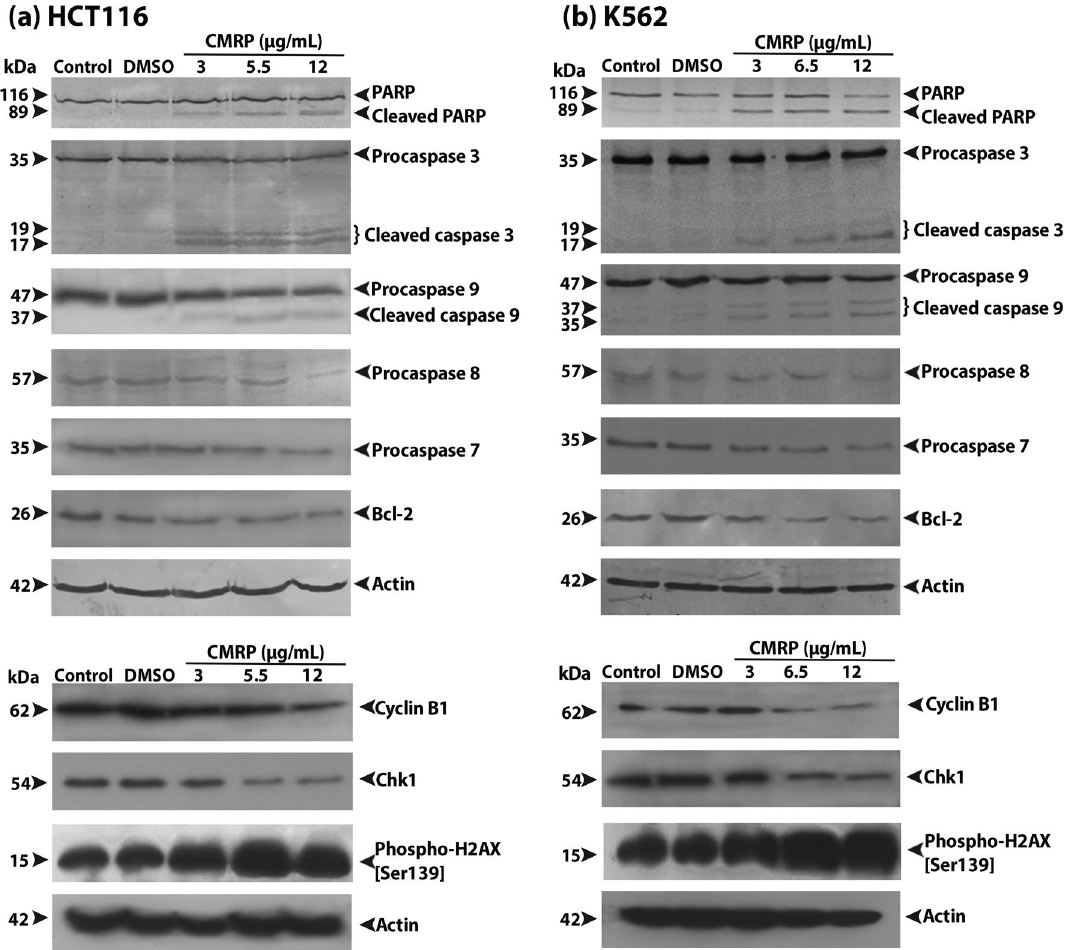
Figure 9. Effect of CMRP on expression of apoptosis and cell cycle related proteins in cancer cells analysed by western blotting. ( a ) and ( b ) Proteins (~ 50 μg) extracted from control and treated HCT116 and K562 cells was resolved on SDS-PAGE followed by western blot analysis using antibodies against PARP, caspase -3, -7, -8, -9, Bcl-2, cyclin B1, Chk 1, and γ-H2AX. β-actin was taken as the loading control. Full length western blots were displayed in Supplementary Figure